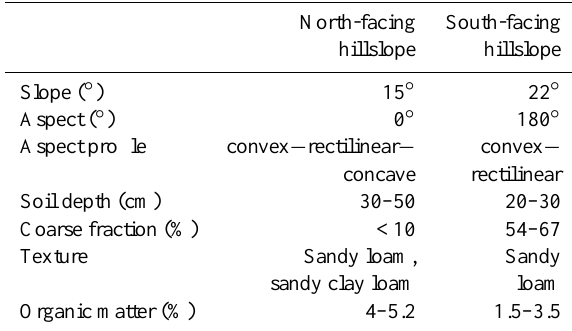
Table 1. Topographical and soil characteristics of the studied hill-